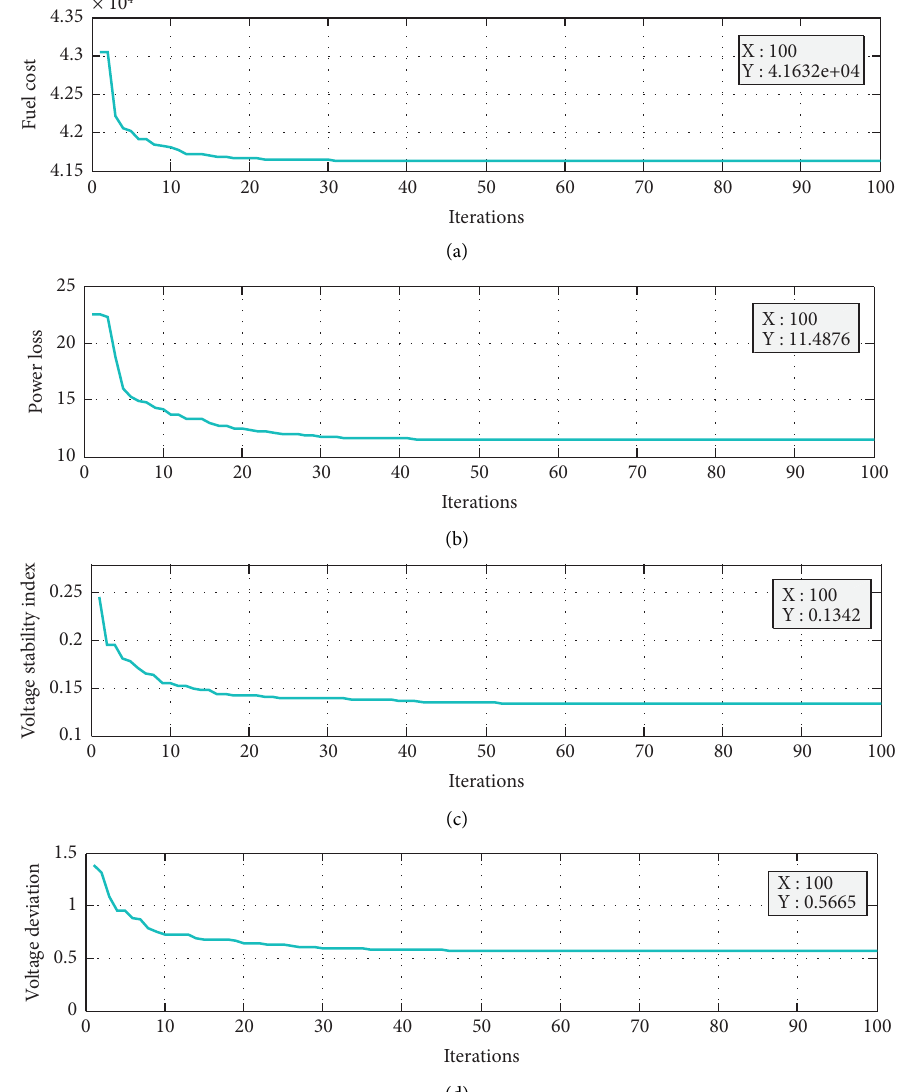
Figure 9: Diference in active power loss reduction (in MW) of proposed technique against other optimization methods reported in literature for the IEEE 57-bus system. × 10 4